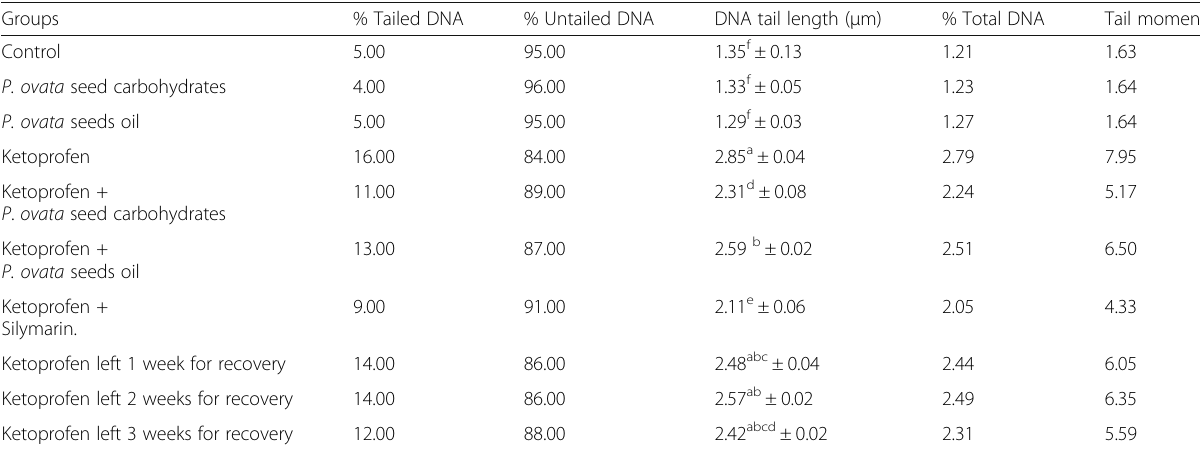
Table 7 Therapeutic effect of P . ovata seed carbohydrates and fixed oil on DNA fragmentation indices of liver tissue in ketoprofen toxicity